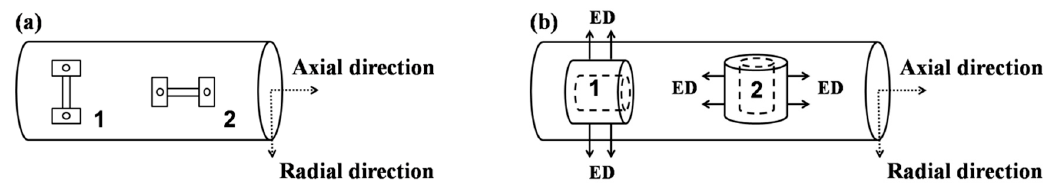
Figure 3. Schematic of the samples used for ( a ) the tensile test and ( b ) the shape memory effect (SME) test.